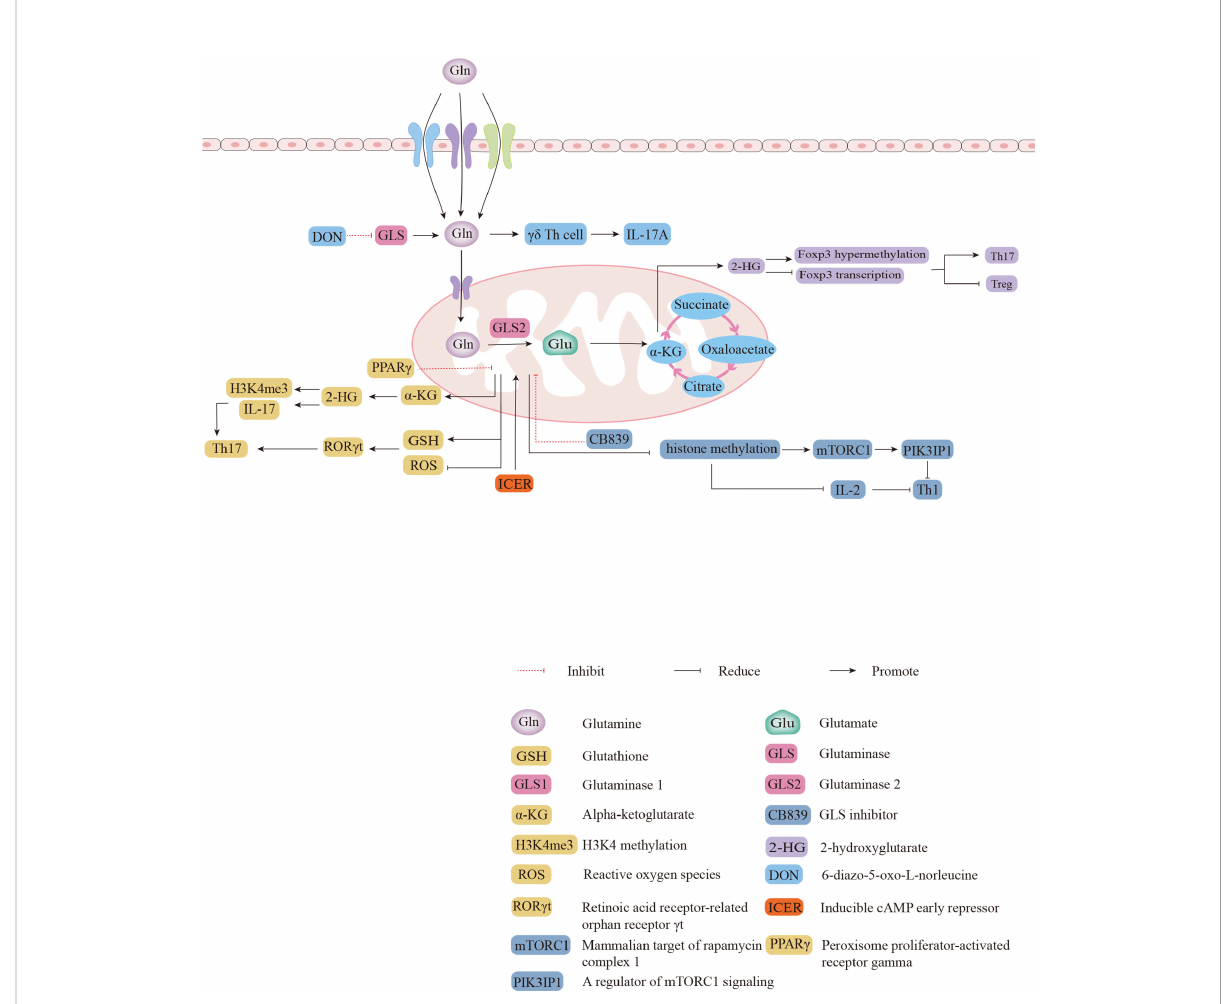
FIGURE 2 The biological functions of glutaminolysis in differentiations of different subsets of CD4 + T cells. 2-HG triggers hypermethylation and represses transcription of the Foxp3 gene to regulate Th17/Treg homeostasis. The expression of IL-17A was reduced in GLS inhibitor DON-treated gd T cells. Direct binding of ICER to GLS1 promotes GLS1 expression and increases the oxygen consumption rate (OCR) of Th17 cells. PPAR g agonists inhibit Th17 responses by eliminating GLS1 through two pathways. Inhibition of mTORC1 and IL-2 signaling by GLS1 with CB839 attenuates Th1